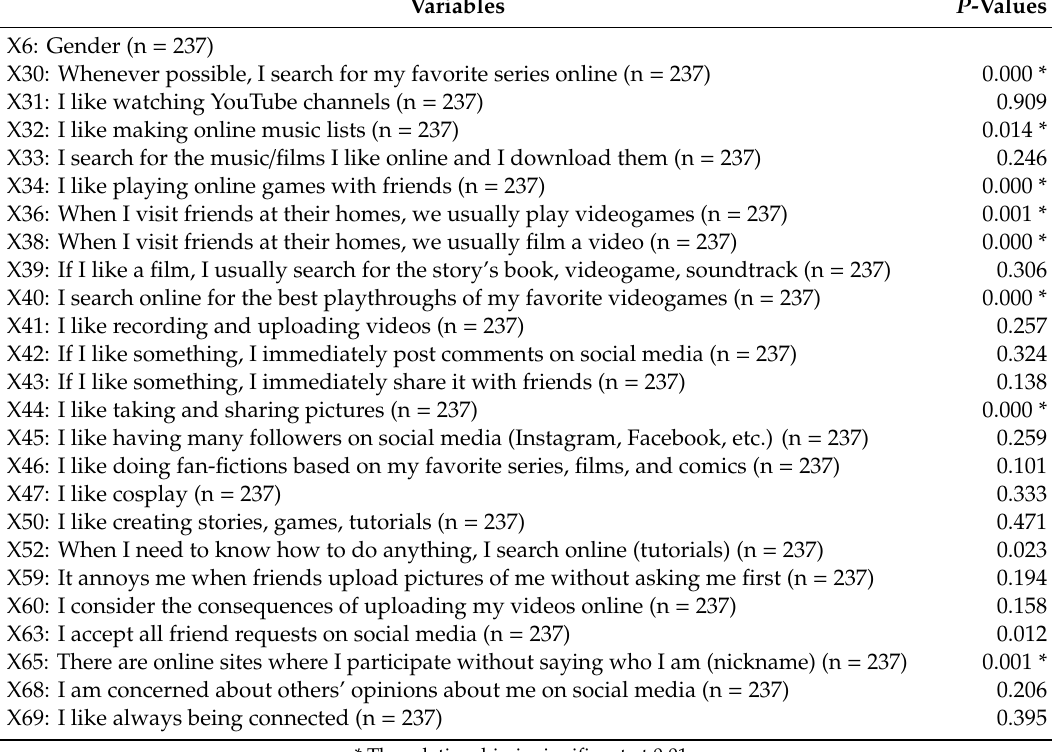
Table 1. P-values of chi-square tests for the independence of nominal variables considered in the study. Variables P